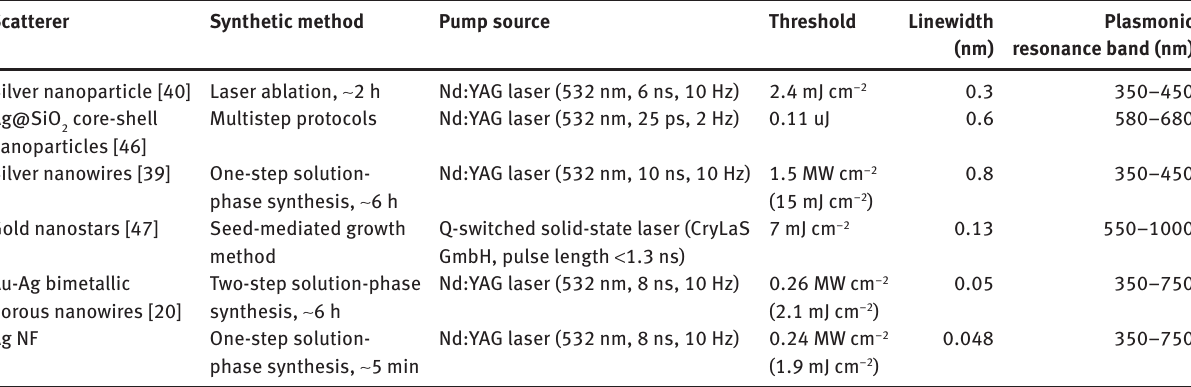
Table 1: Comparison table of the surface plasmonic random lasers.